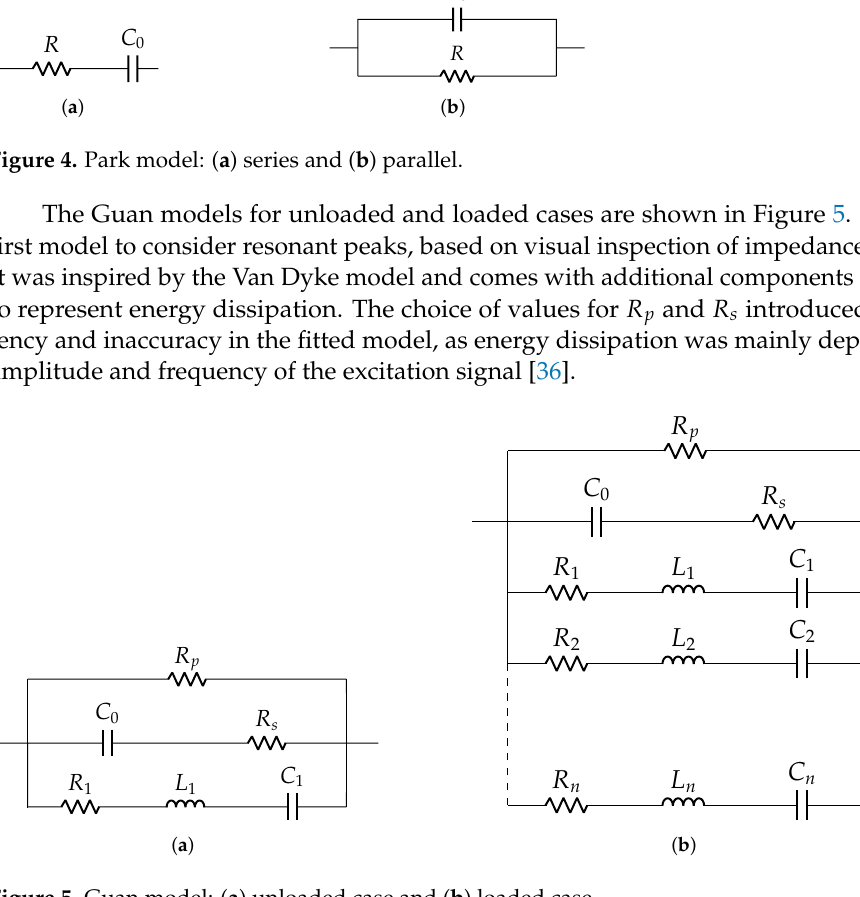
Figure 5. Guan model: ( a ) unloaded case and ( b ) loaded